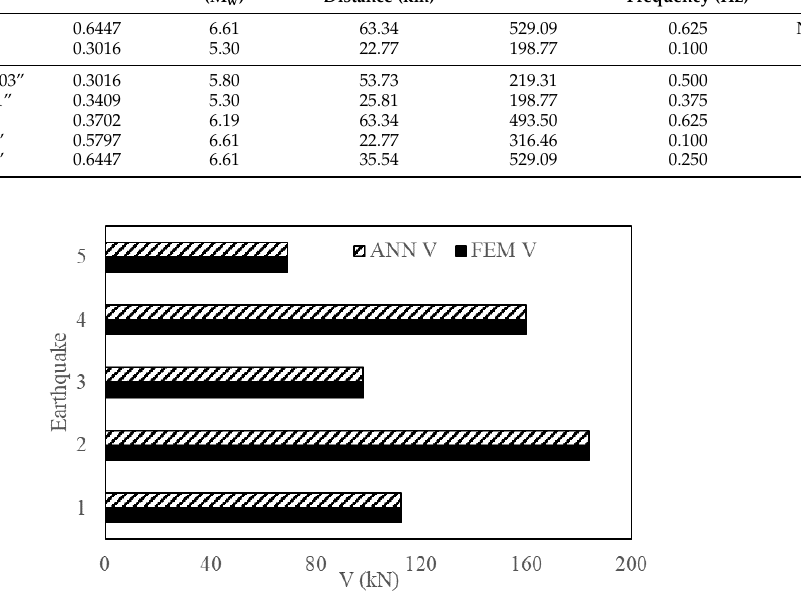
Figure 13. Base shear of a four-story structure obtained from ANN and NLTHA for five EQs.